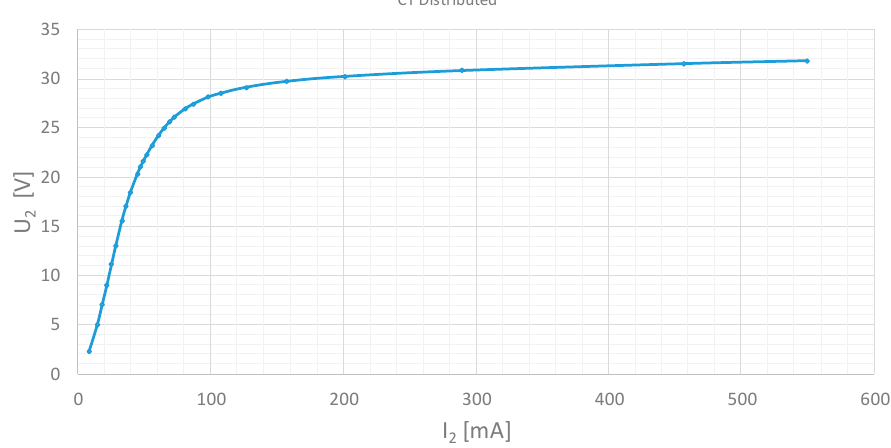
Figure 6. Excitation test result. Current transformer 500/1A 5P10 1VA. Distributed secondary winding.